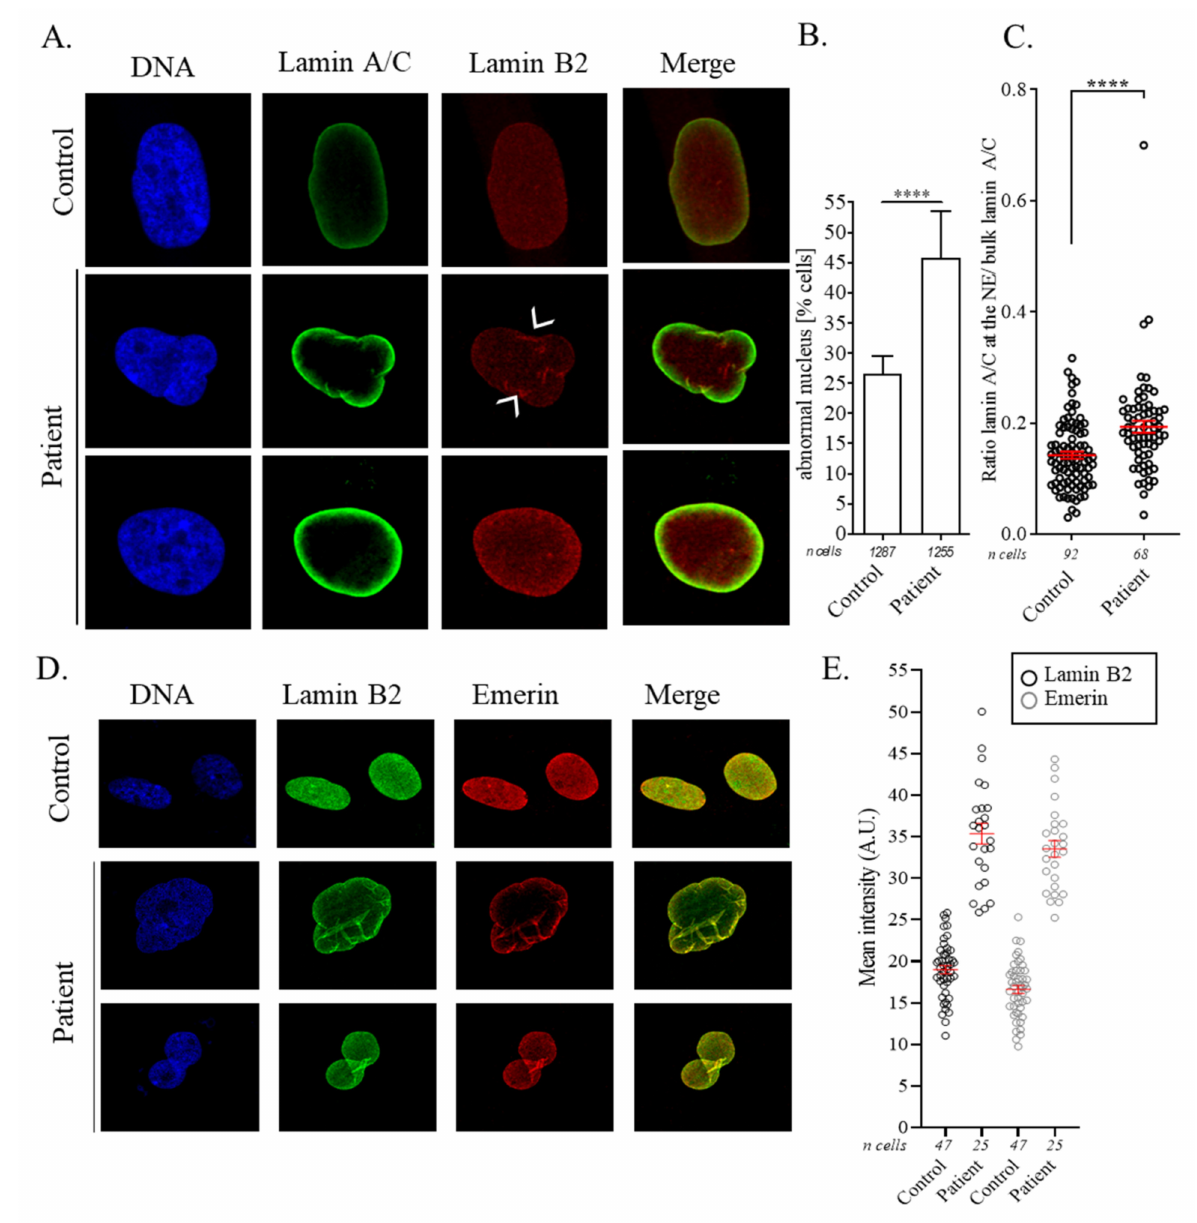
Figure 4. LMNB2 p.(Arg234Trp) mutation induces abnormally shaped nucleus, lamin B2 aggrega- tion, and lamin A/C preferential location at the nuclear envelope. ( A ) Confocal images showing abnormally shaped nucleus, lamin B2 aggregation, and intense lamin A/C signal at the nuclear envelope of patient fibroblasts compared with control. Lamin A/C (green) and B2 (red) were marked with appropriate antibodies and DNA with Hoechst. White arrowheads designate typical lamin B2 aggregates. ( B ) The graph shows the percentages of cells with abnormally shaped nuclei, means +/ − standard error (SE) from three independent experiments. ****, p < 0.0001 compares patient with control nucleus by the Fischer exact test. ( C ) Ratio of lamin A/C signal at the nuclear envelope and in the nucleus. Means +/ − SE from three independent experiments. ****, p < 0.0001 compares patient with control condition by the Mann–Whitney test. ( D ) Confocal images showing co-staining of emerin and lamin B2 in abnormally shaped nuclei. Lamin B2 (green) and emerin (red) were marked with appropriate antibodies and DNA with Hoechst. ( E ) The graph depicts the mean intensity at the nuclear envelope of lamin B2 (grey) and emerin (blue) for control and patient cells. Means +/ − SE from one